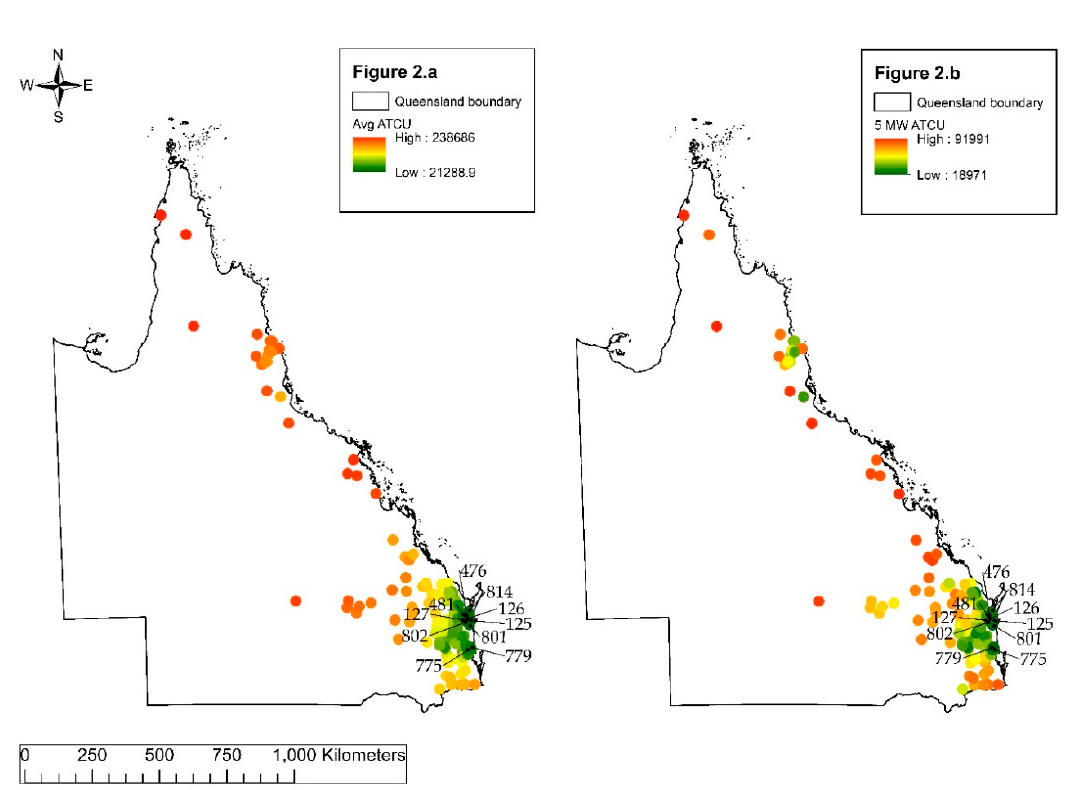
Figure 3. Location “476” and its respective connection with the forest to satisfy respective capacities of 5, 10, 20, 50 and 100 MW.